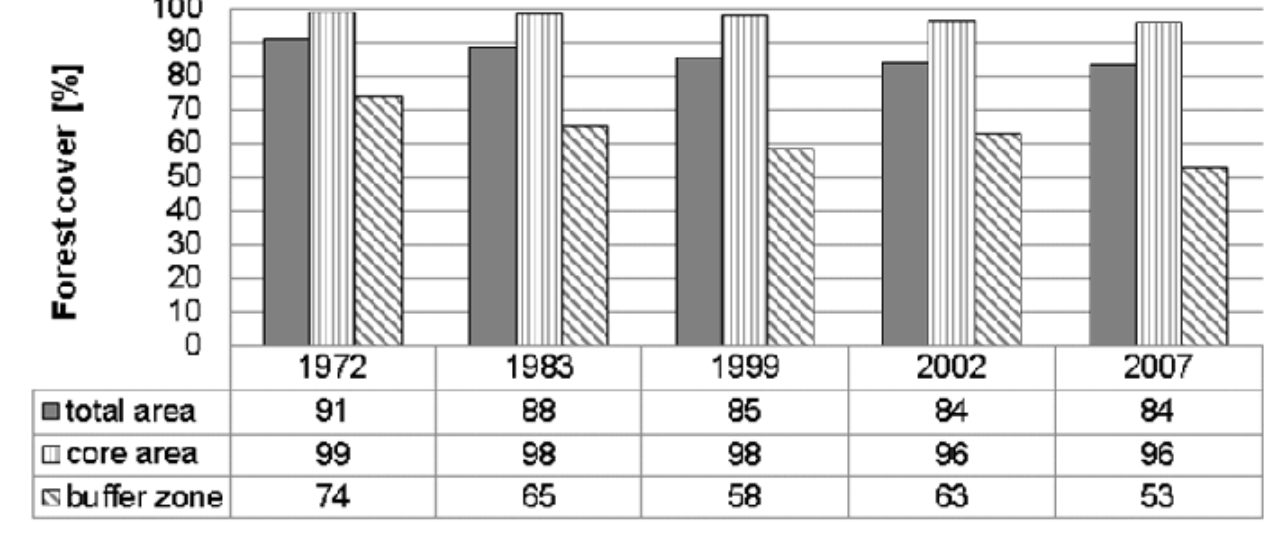
Fig. 3 . Forest cover (%) in Lore Lindu Biosphere Reserve between 1972 and 2007. Data source: Stability of Rainforest Margins Project (STORMA), University of Göttingen, Germany; own illustration.